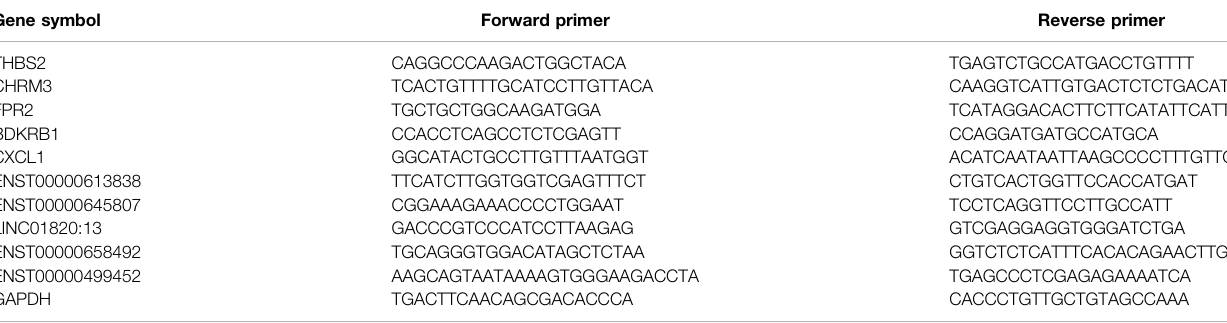
TABLE 1 | Sequences of primers used for qRT-PCR